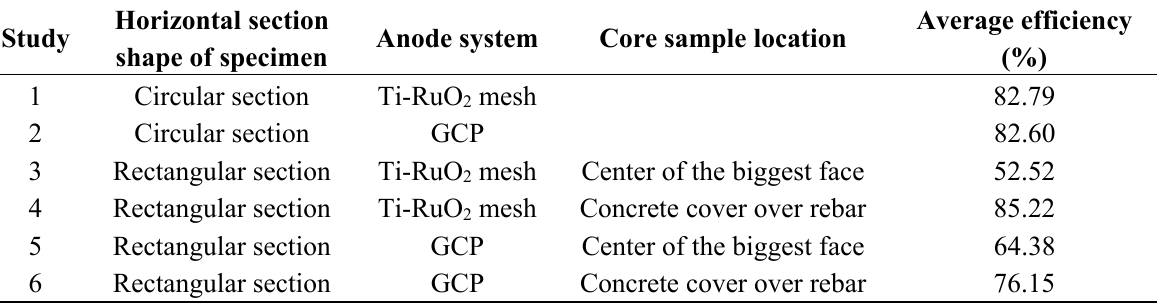
Figure 12. Comparative efficiency results for studies 3, 4, 5 and 6. Rectangular section specimens. ECE efficiency average with Ti-RuO 2 mesh was 52.52% in the vertical axis of the largest side and 85.22% in the concrete cover, whereas for GCP, results were 64.38% and 76.15% for the same locations. Table 3. Summary of obtained efficiencies in the different studies carried out applying ECE to vertical shape specimens of reinforced